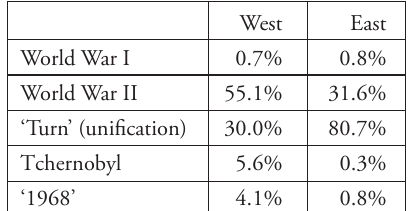
Table 1: Historical watersheds in West